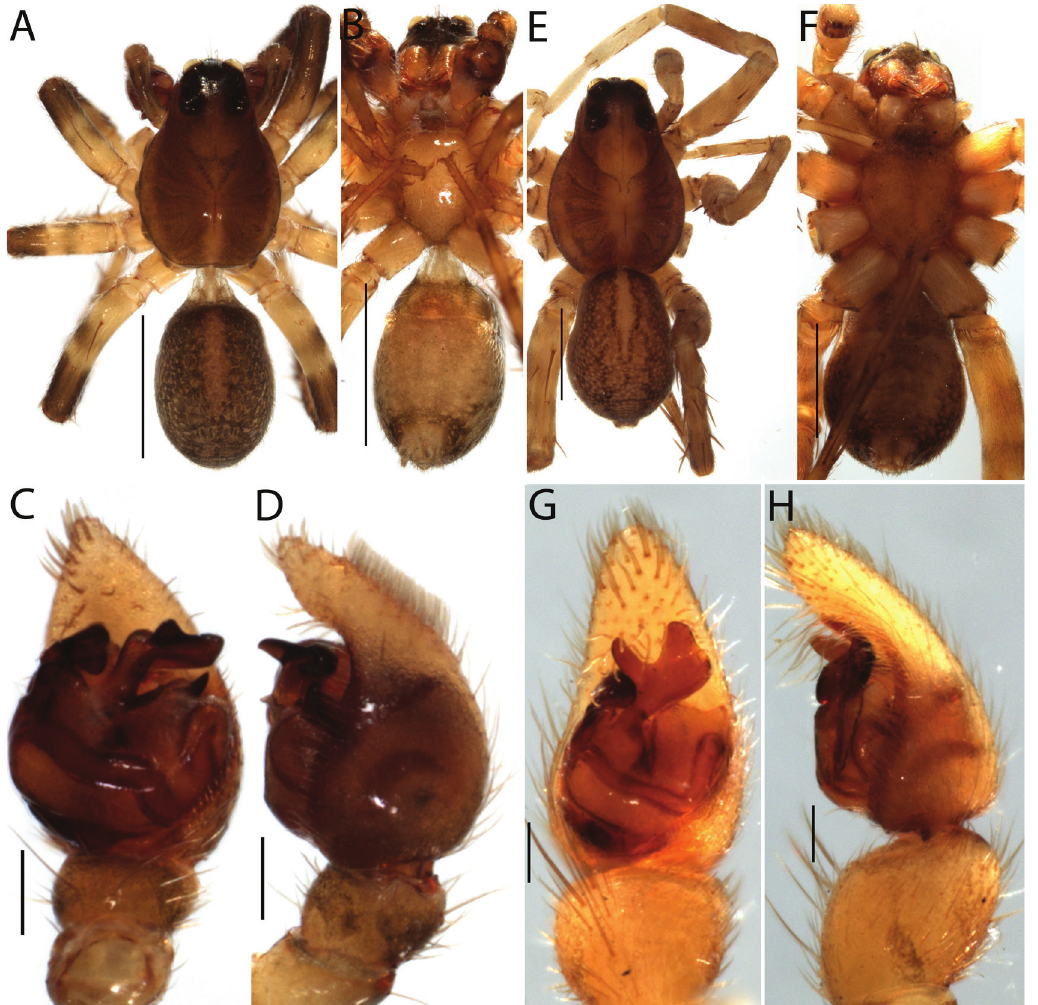
Figure 29. A–D , Artoria maroota sp. n. , male holotype (AM KS128075), E–H , Artoria myallensis sp. n. male holotype (AM KS84055): A , habitus, dorsal view; B , habitus, ventral view; C , male pedipalp, ventral view; D , male pedipalp, retrolateral view; E , habitus, dorsal view; F , habitus, ventral view; G , male pedipalp, ventral view; H , male pedipalp, retrolateral view. Scale bars: habitus 1.0 mm; palp 0.1